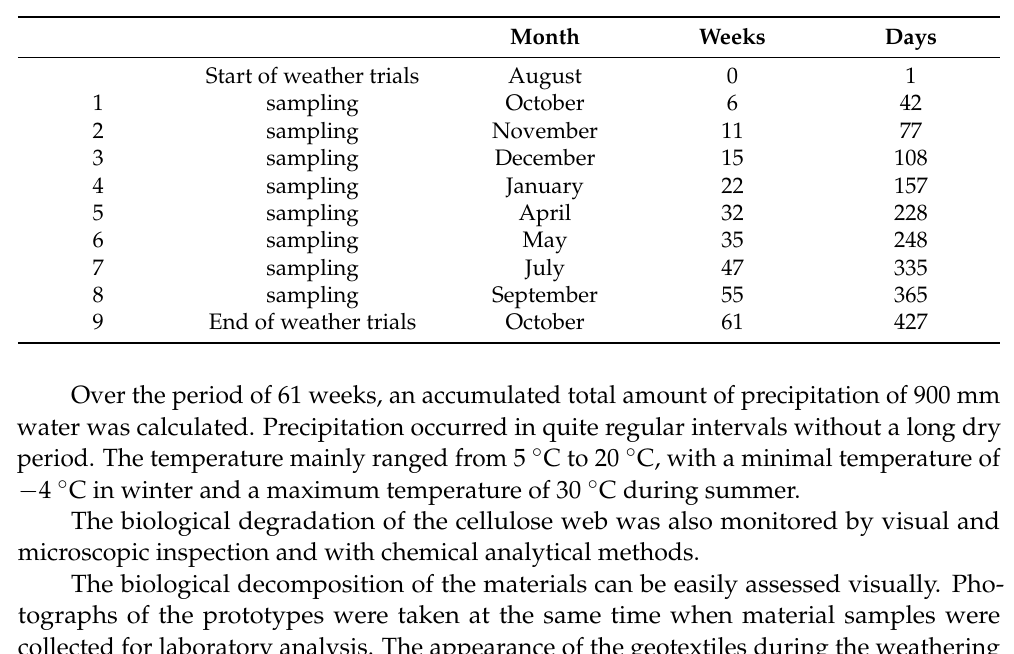
Table 2. Period of the degradation tests and sampling